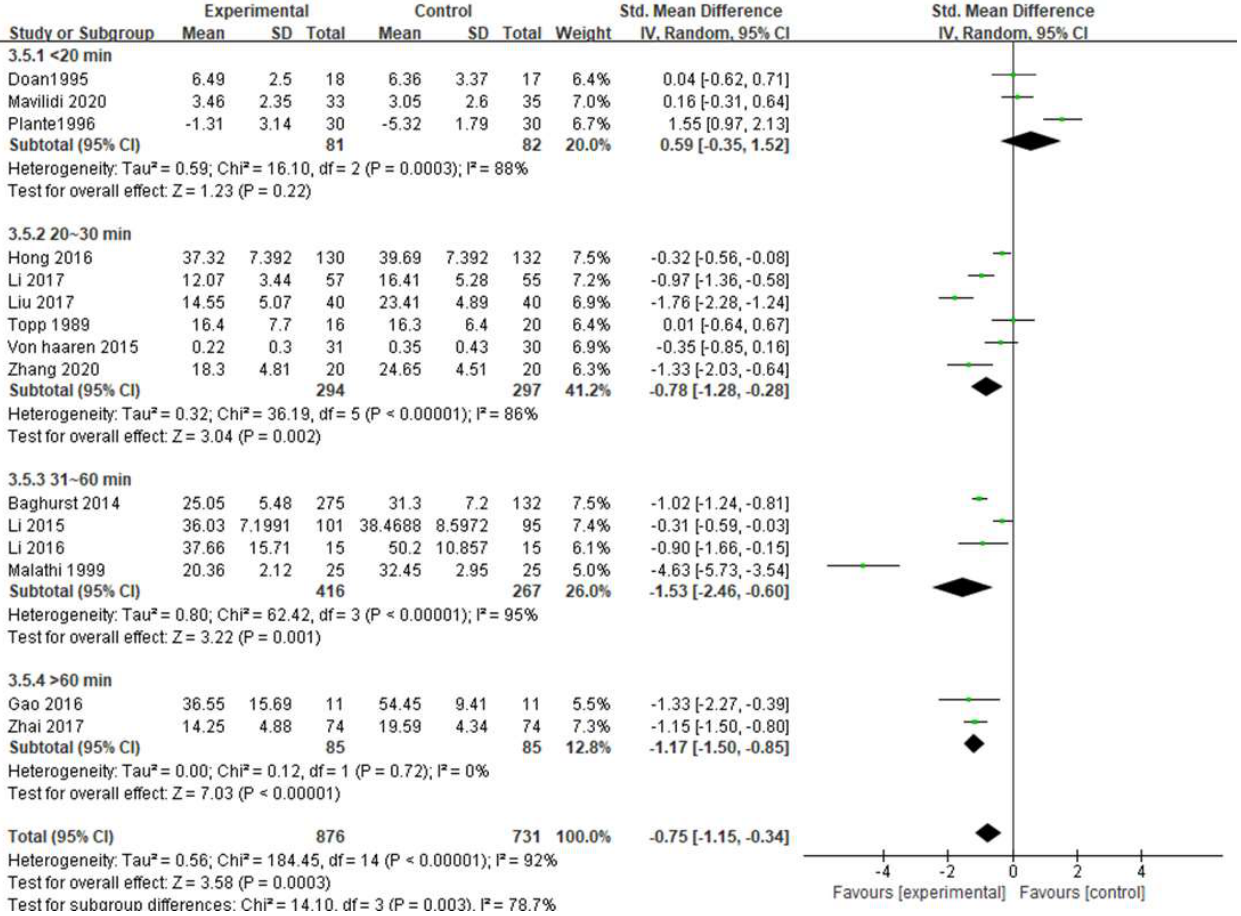
Figure 10. Subgroup analysis of exercise duration [17–20,22–32].